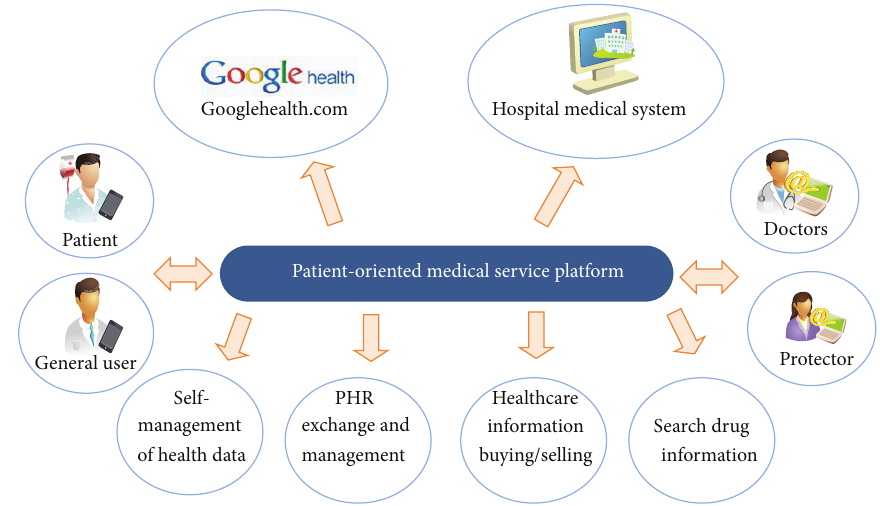
Figure 4: Concept diagram of patient-oriented health data management